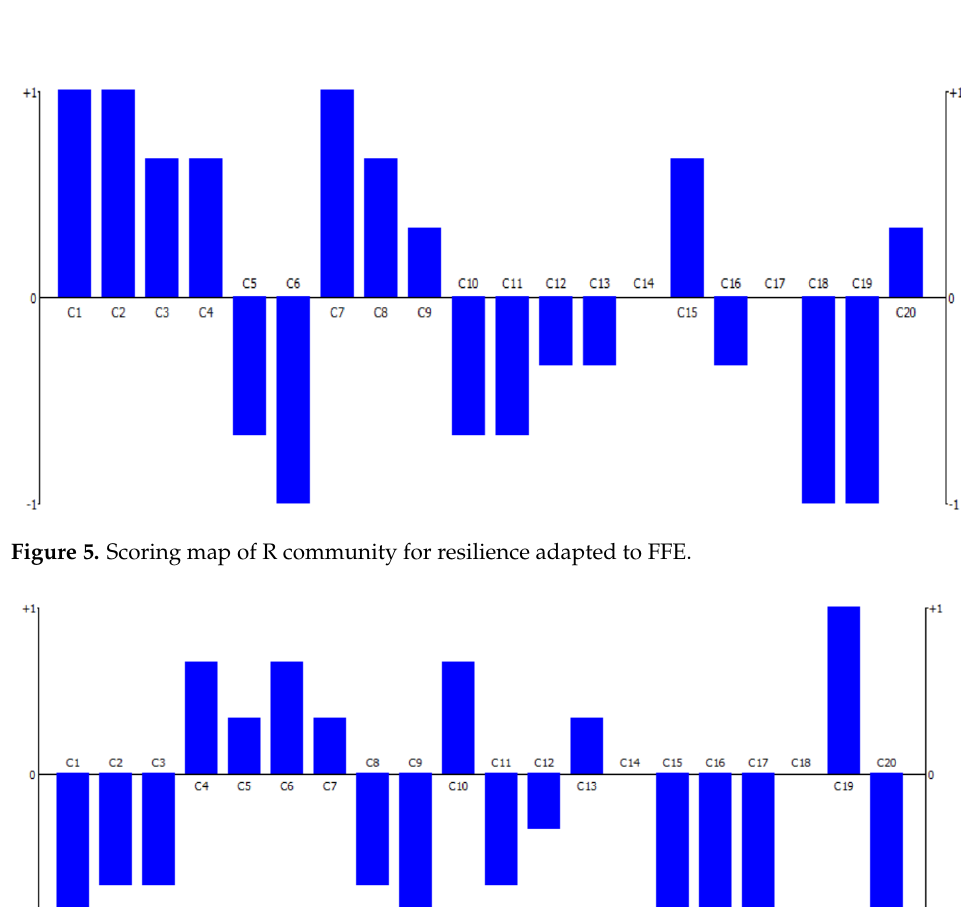
Figure 4. Scoring map of J community for resilience adapted to FFE.